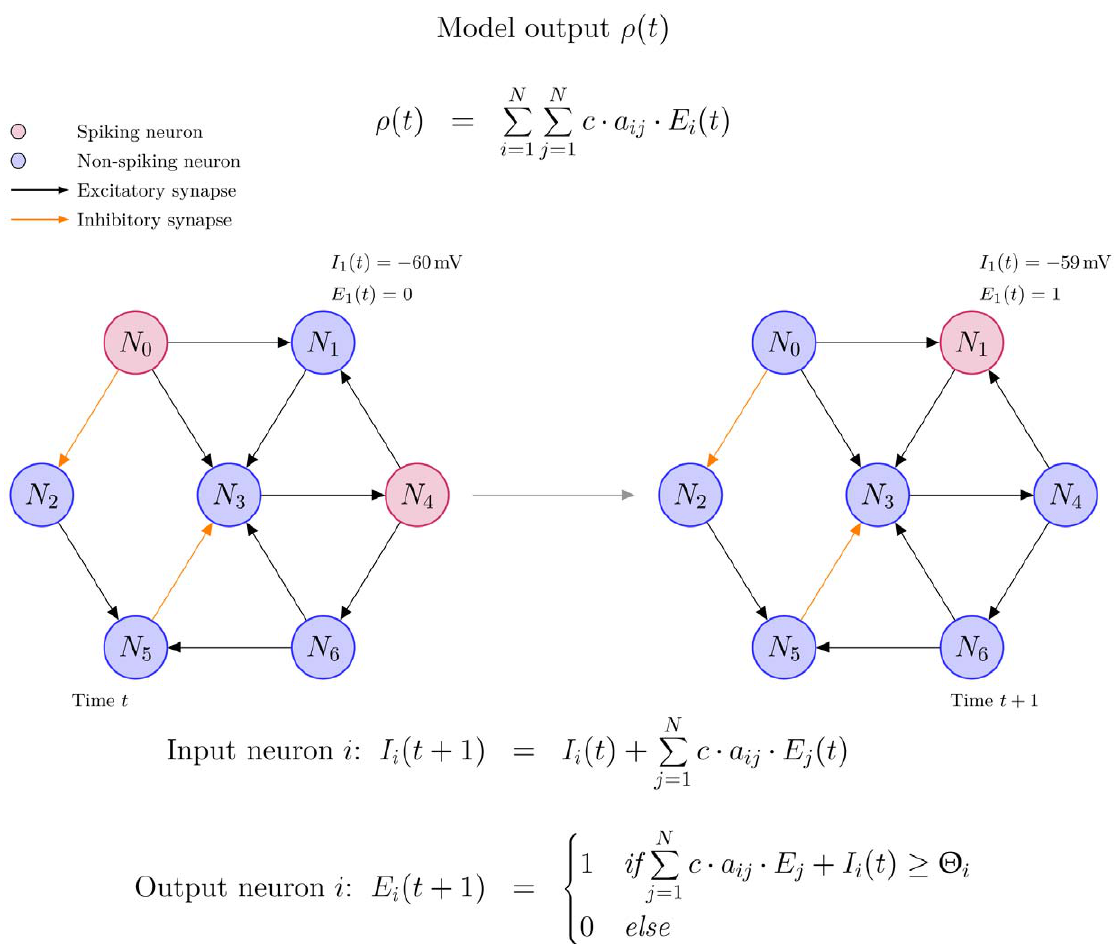
Figure 1. Example cluster of 7 neurons for the time evolution of our model (left panel: time t=1 and right panel: t=t + 1. Spiking neurons are coloured red, non-spiking neurons are coloured blue. Synaptic connections between the neurons are either excitatory (black) or inhibitory (orange). The functions I i (t) and E i (t) describe the input and output of each neuron. The threshold H i triggers the generation of a spike and is set to 2 60 mV. The constant c is denoting the change in postsynaptic potential triggered by the arrival of an action potential (AP) at the synaptic cleft. The model output r (t) consists of the sum of the output E i (t) of all neurons.